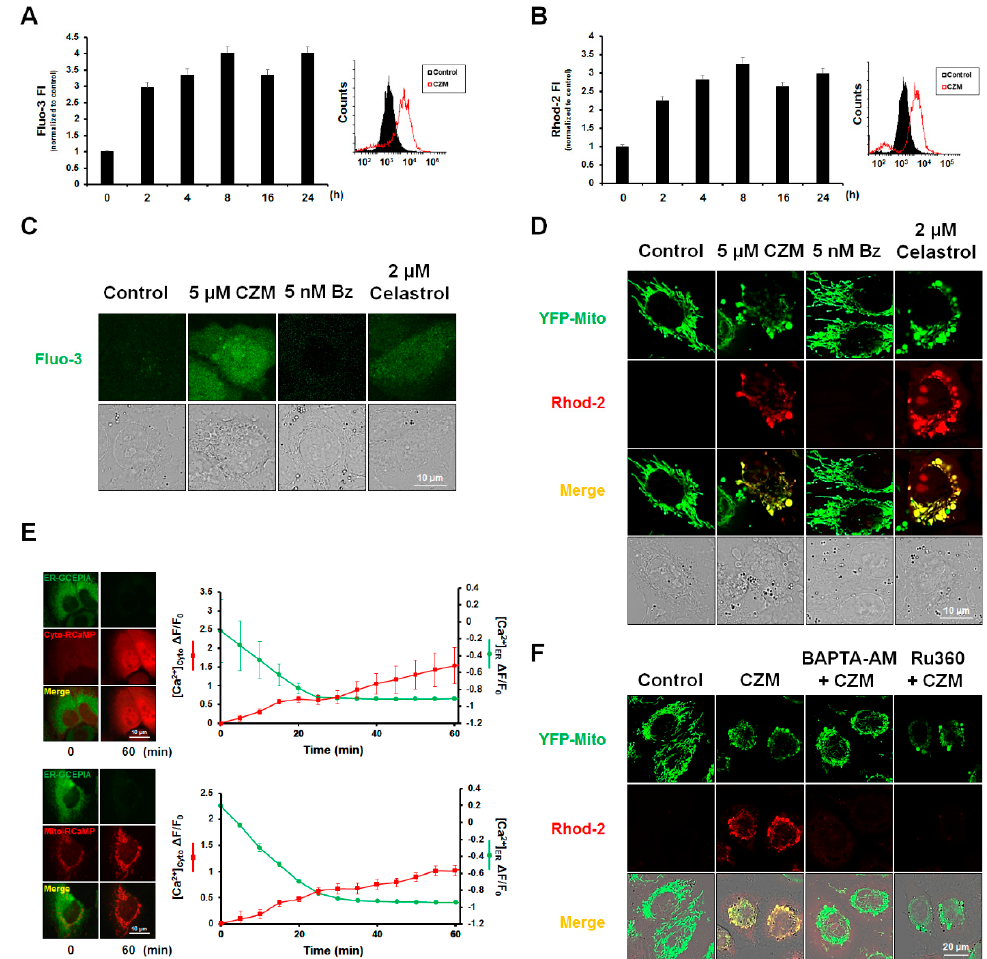
Figure 4. PSMD14 inhibition induces intracellular Ca 2+ imbalance in MDA-MB 435S cells. ( A , B ) MDA-MB 435S cells were treated with 5 μ M CZM for the indicated time durations, stained with Fluo-3 ( A ) or Rhod-2 ( B ) and processed for FACS analysis. The results of FACS analysis after treatment with 5 µ M CZM for 8 h are depicted in the graphs. ( C ) MDA-MB 435S cells treated with the indicated chemicals were observed under the confocal microscope. Bars, 10 µ m. ( D ) YFP-Mito cells treated with the indicated chemicals were stained with Rhod-2 and observed under the confocal microscope. Celastrol was used as a positive control to confirm the increase in Ca 2+ in the cytosol and mitochondria. Bars, 10 µ m. ( E ) MDA-MB 435S cells transfected with the plasmids encoding G-CEPIA1er and cyto-RCaMP1h or cells transfected with those G-CEPIA1er and mito-RCaMP1h were treated with 5 µ M CZM for the indicated time durations. Subcellular Ca 2+ dynamics were monitored under the confocal microscope, and representative images were displayed. Bars, 10 µ m. Time course Ca 2+ signal in the ER, cytosol, and mitochondria in CZM-treated cells was analyzed using Image J/Fiji software. ( F ) YFP-ER cells pretreated with 10 µ M BAPTA-AM or 20 µ M Ru360 were further treated with 5 µ M CZM for 8 h and stained with Rhod-2. Cells were observed under the confocal microscope. Bars, 20 µ